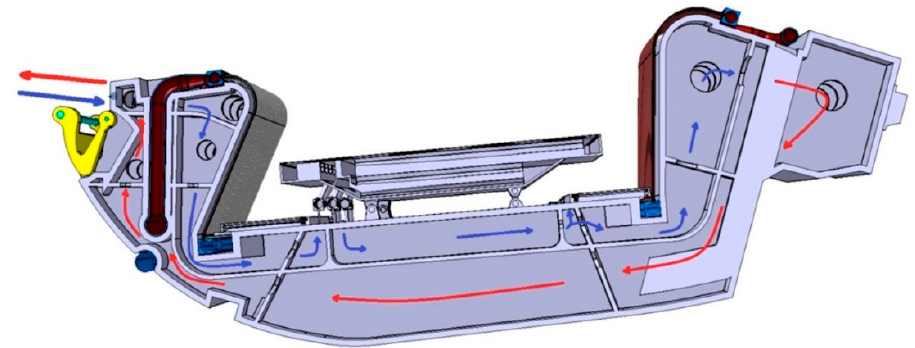
Figure 3. Divertor assembly section with detail of cassette section and cassette cooling path [15].